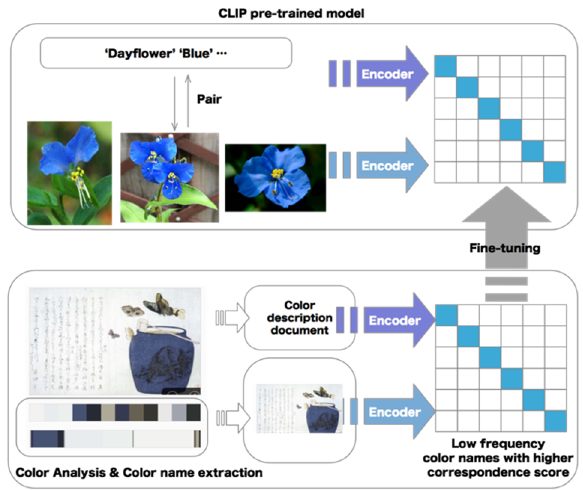
Table 14. Top 3 results for query ‘Blue’ and ‘Dayflower blue’. Figure 18. Example of extracting rare color information based on our proposed method.